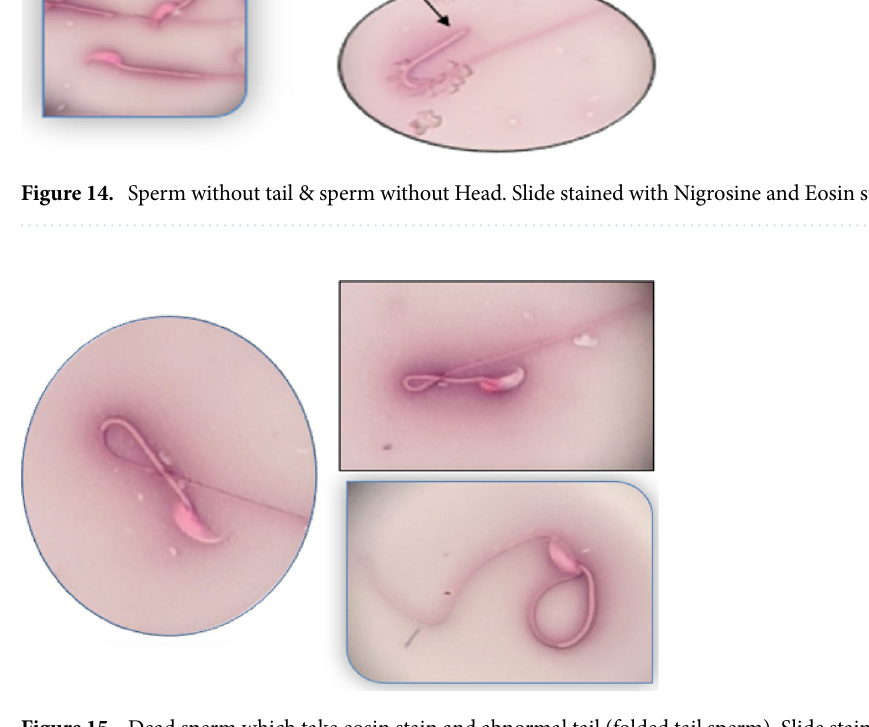
Figure 15. Dead sperm which take eosin stain and abnormal tail (folded tail sperm). Slide stained with Nigrosine and Eosin stain